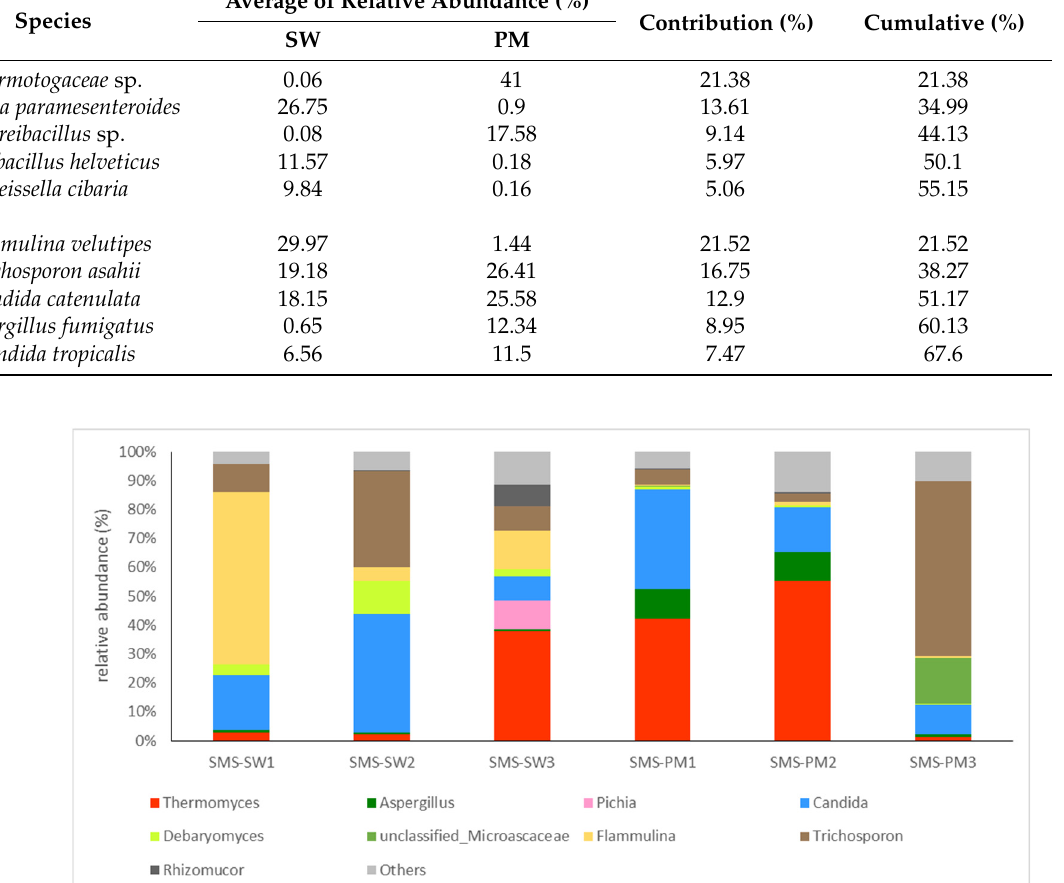
Figure 3. Dynamic changes of the fungal community at the genus level from spent mushroom substrate with soy wastes (SMS-SW) and with swine and poultry manure (SMS-PW). The relative abundance of genus was >0.1% in at least one sample. Genera with relative abundance <0.1% were grouped as “others”.